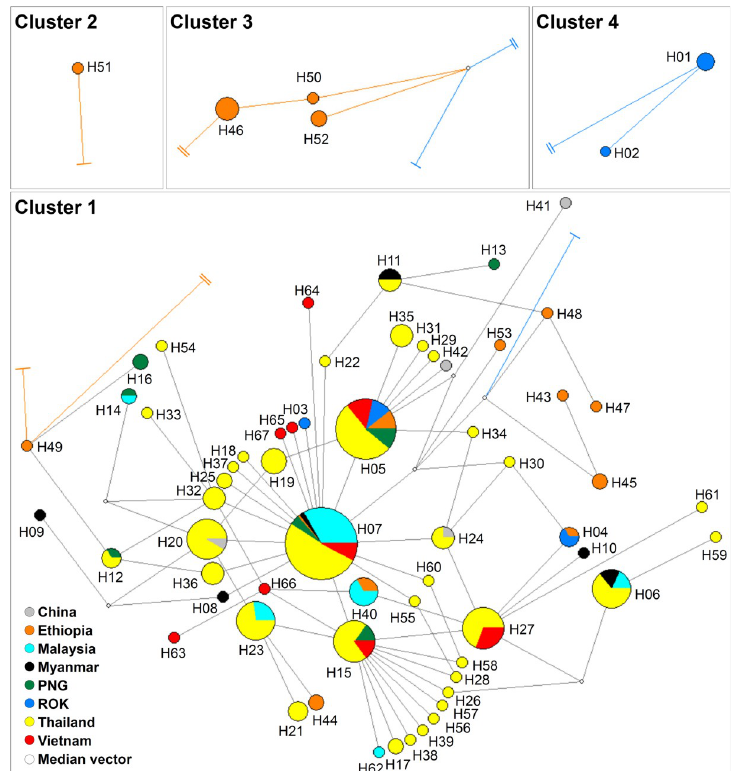
Fig 2. Median-joining networks of PvEBP-ecto haplotype. The geographical haplotype network shows the relationships among 67 haplotypes present in 316 isolates sequence. Distances between nodes are generated by NetWork 5.0 software. The orange cutting line connected to cluster 2 and cluster 3, the blue cutting line connected to cluster 4. The cluster 3 and cluster 4 contained large insertion sequence in RIII-V domain and cluster 4 connected to PcyM